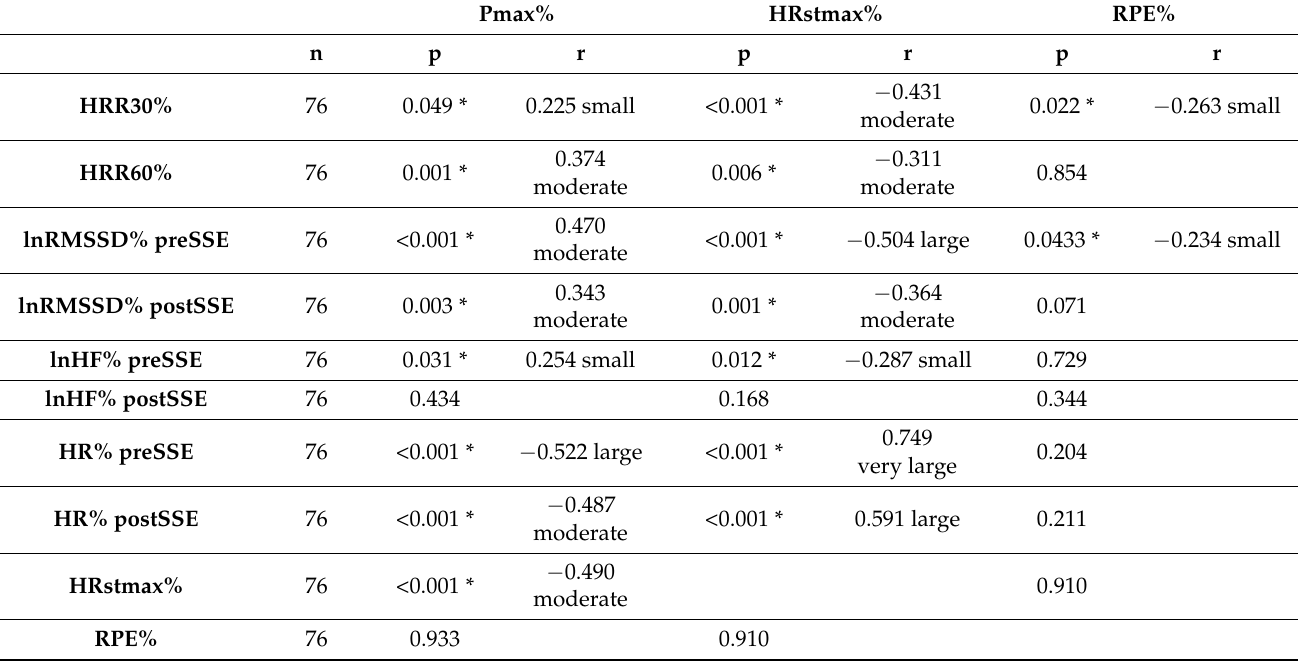
Table 4. Relationship between the change in all measured cardiac indices, the change in performance, and in RPE with respect to baseline values combined for all data after prolonged